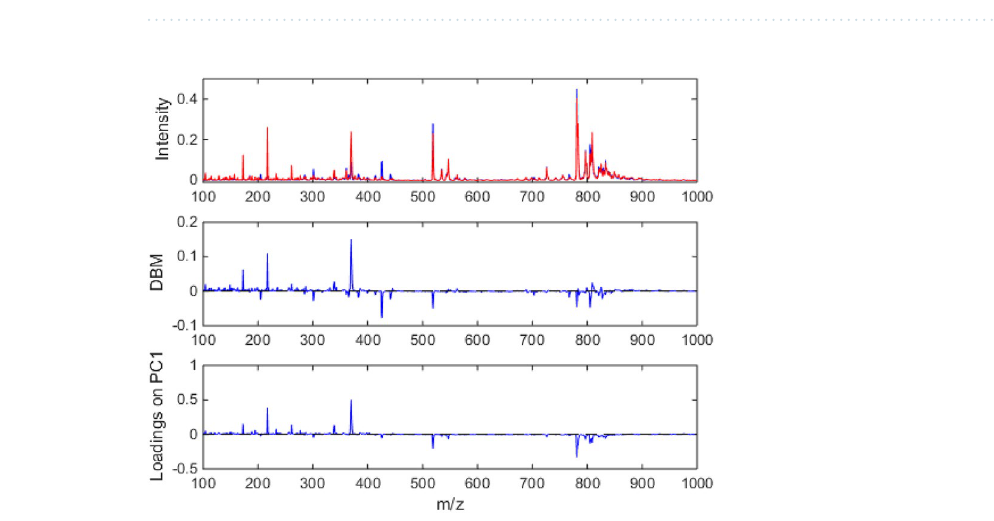
Table 2. Selected variables (m/z) in PCA and supervised models.